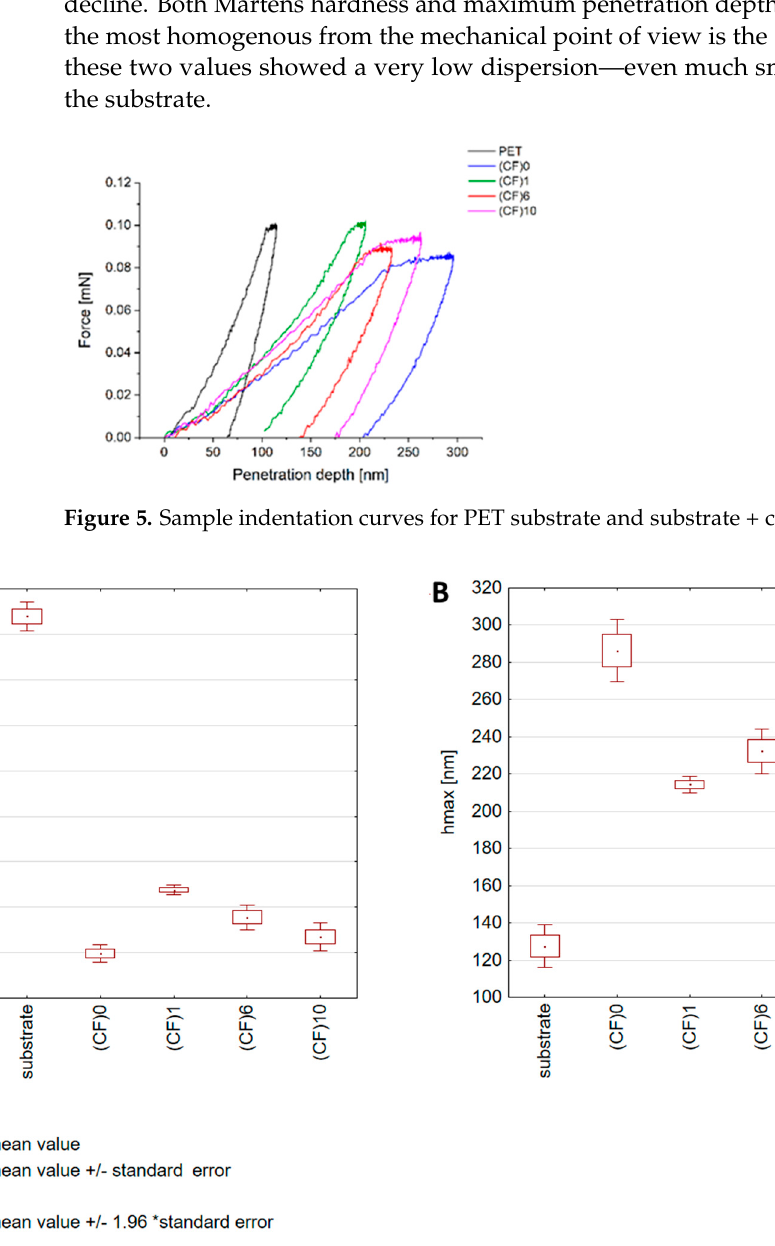
Figure 6. Results of nanoindentation test, average values for each material: ( A )—Martens hardness and ( B )—maximum penetration depth of the indenter.